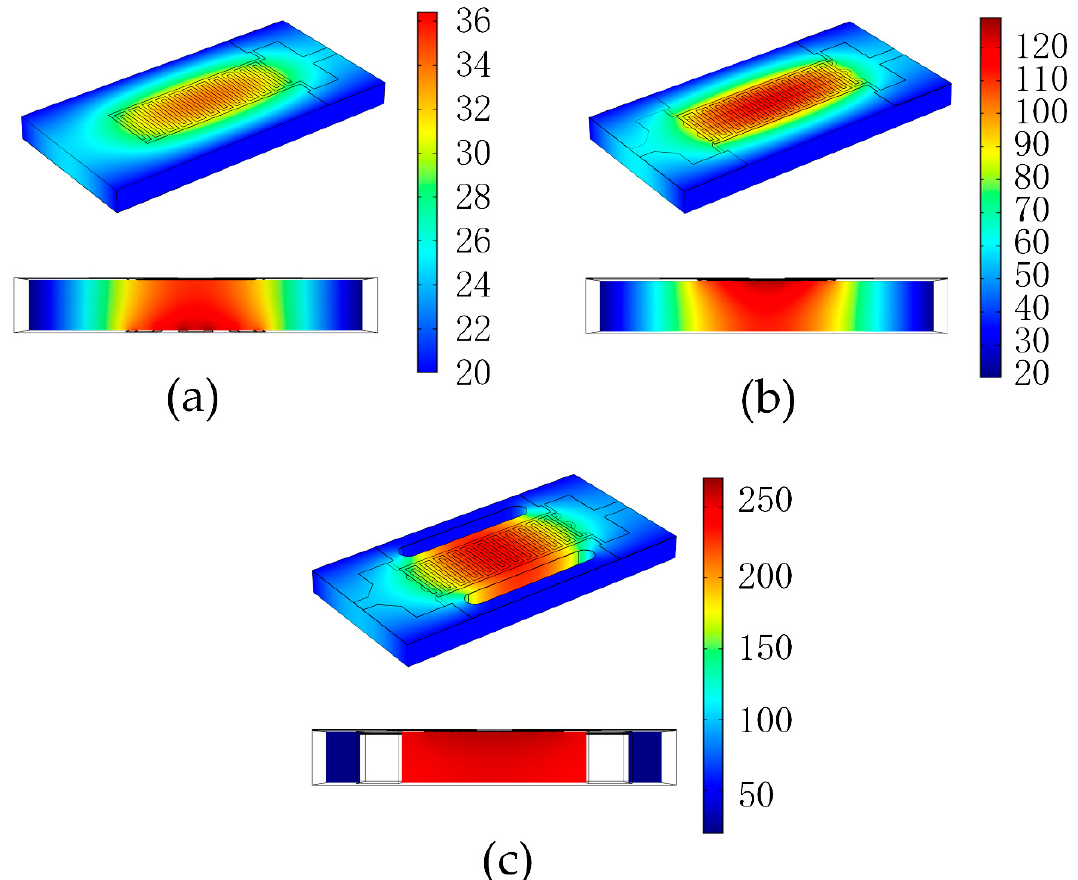
Figure 8. Simulation results of the ( a ) first, ( b ) second, and ( c ) third designs. The third design blocks the transfer of heat to the two surfaces of the micro-hotplate, which are in contact with each other and the outside world through holes on the left and right sides. The cross-sectional view in the simulation shows that the heat released by the heating resistor is mostly concentrated at the location of the interdigital electrodes, and the maximum temperature of the surface can reach 269 ◦ C, which is an increase of 141 ◦ C or 110% compared with the results of the second solution. The temperature data obtained by reading the temperature data along the x-axis at the center of the upper surface of the micro-hotplate in each of the three simulation models are given in Figure 9a. It can be observed that the first design has a very smooth temperature gradient, but the maximum temperature is too small to meet the requirements. The second design has a linear change in temperature gradient, but the third design is clearly superior and has good temperature uniformity in the area of the micro-hotplate, where the sensor material is coated. The breaks in temperature values on either side of the graph are due to the disconnected through-holes, which are designed to isolate the heat loss to some extent. Figure 9b presents the temperature at the highest point as a function of voltage obtained by simulating three designs with voltages between 2 V and 20 V applied in intervals of 2